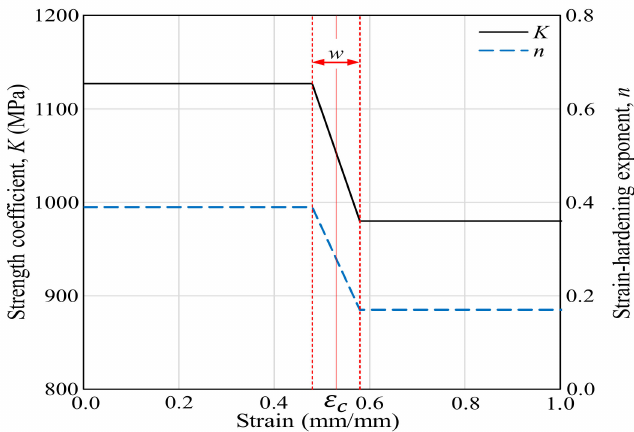
Figure 3. The strength coe ffi cient and the strain-hardening